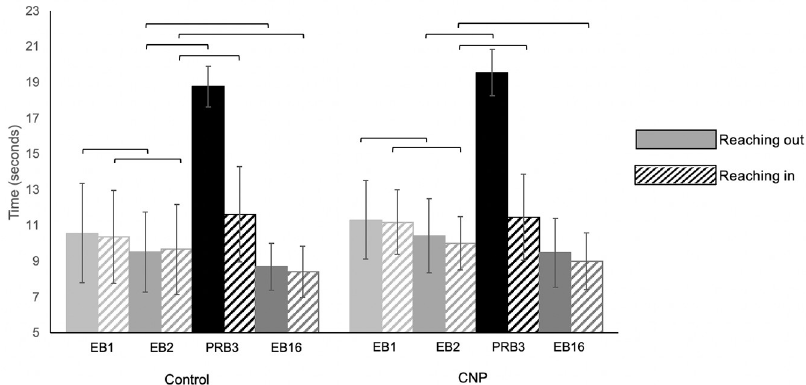
Fig 2. Explicit motor learning. Following practice, participants completed two blocks of outward and inward reaching to a known pattern of targets (EB1 and EB2). Bars represent the average time to complete the upper limb reaching task. Reaching outward movements are represented by solid bars, inward reaching movements by striped bars. After the two explicit motor learning blocks a pseudo-random catch block (PRB3) was introduced to assess explicit motor learning. The stability of explicit motor learning was later assessed at the end of the trial in EB16. Error bars represent standard deviations. Brackets indicate a significant within-group difference according to a Sign test, p <